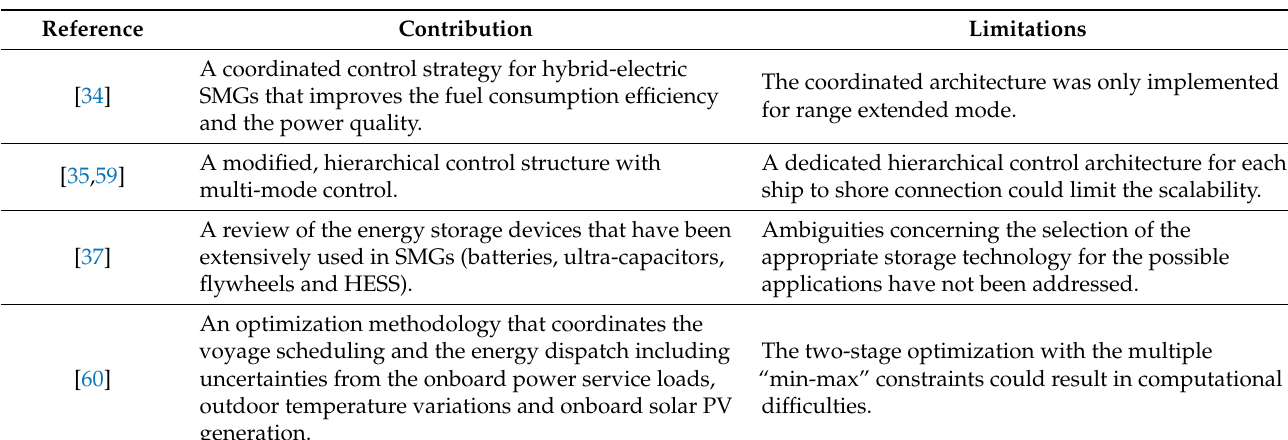
Table 4. Main contributions in recent literature focusing on